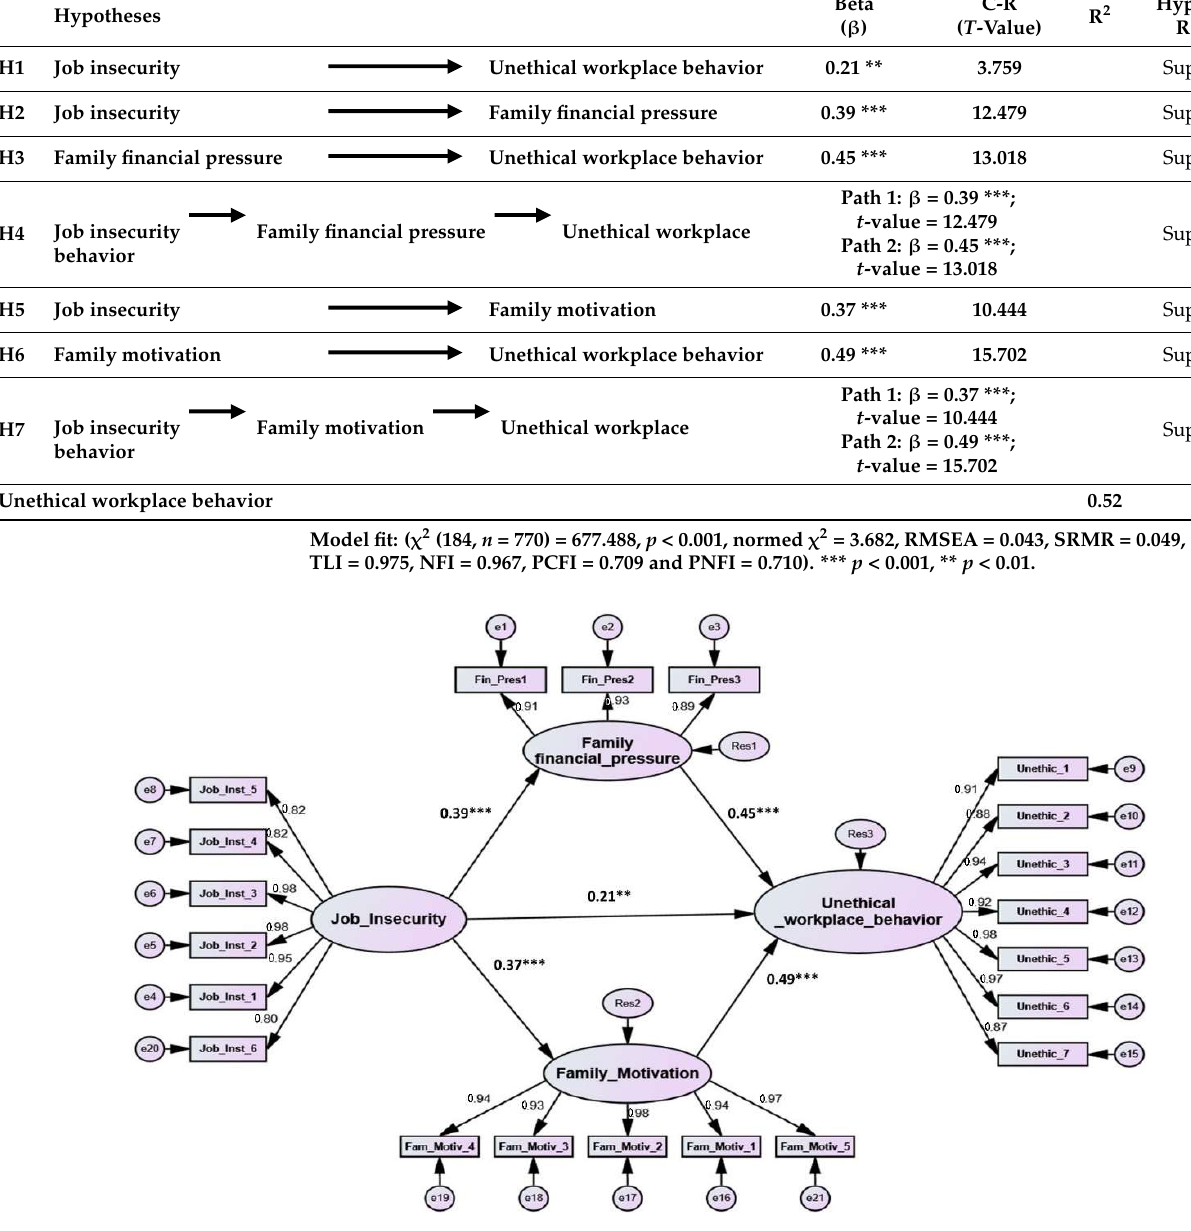
Table 3. Result of structural model.